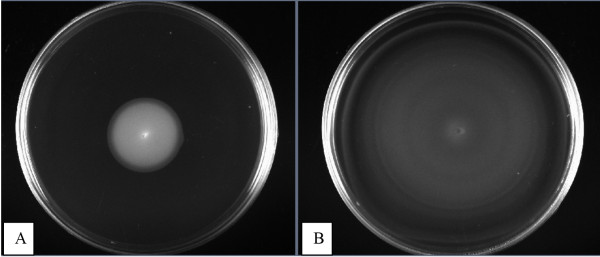
Swarming and swimming behaviour of Salmonella enterica serovar Typhi. Swarm medium is nutrient broth (0.5% agar) and swim medium (0.25% agar) supplemented with glucose as carbon source (0.5% [wt/vol]). Uncolonised agar is black and bacteria biomass is white. All images were captured after 24 hr at 37°C. Panel A shows swarming motility. Panel B shows swimming motility.